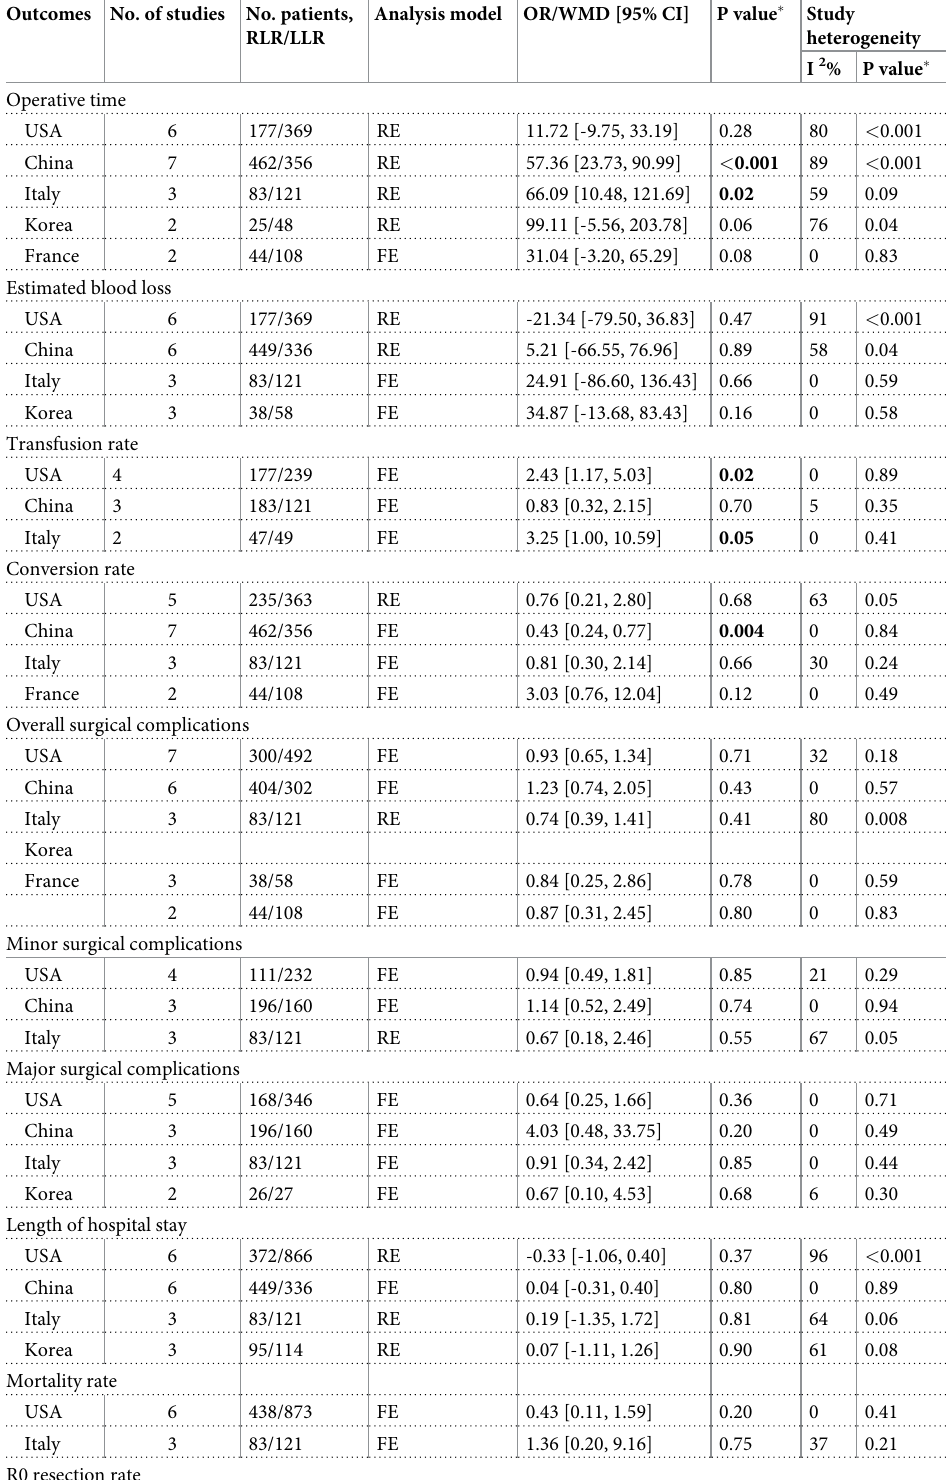
Table 2. Subgroup analysis of different country. Outcomes No. of studies No. patients,